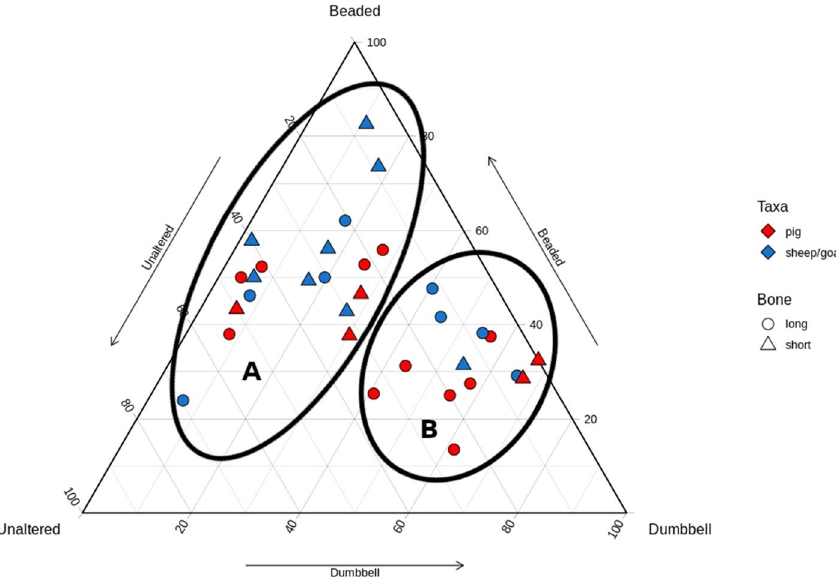
Figure 9. Ternary plot of all samples, where Slightly Beaded fibrils were included with Unaltered under the assumption that Slightly Beaded changes were the result of burial environment, not heat treatment. The two groups are consistent with the samples’ classification from the earlier analysis, and demonstrate that distinction is still possible, though less obviously two distinguished groups.